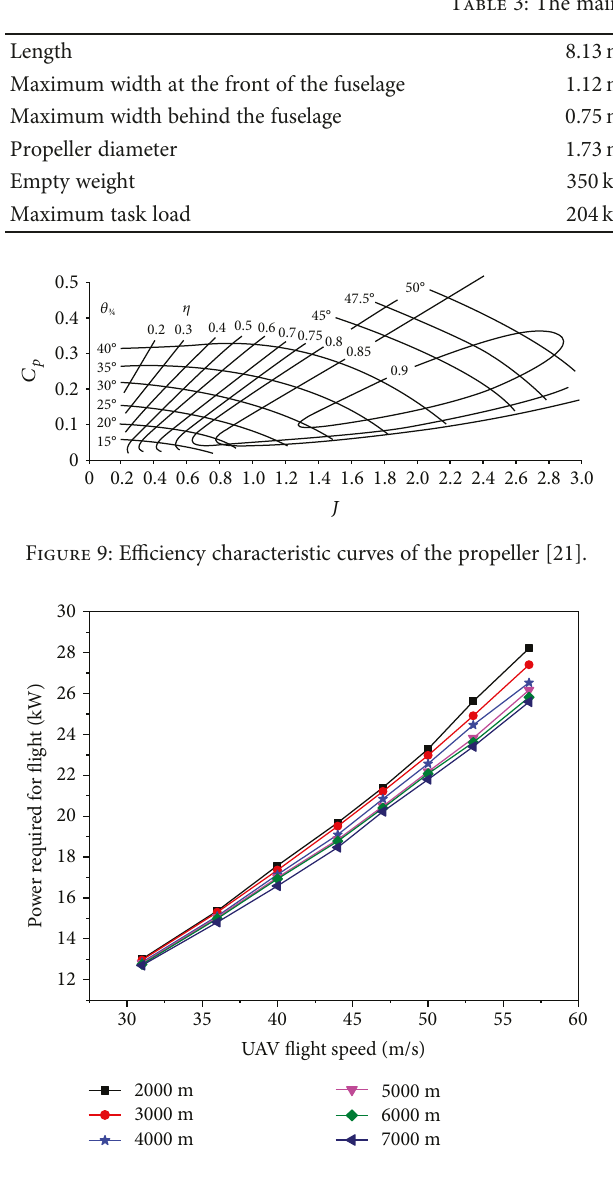
Figure 10: Power requirements for UAV fl ight at di ff erent altitudes.